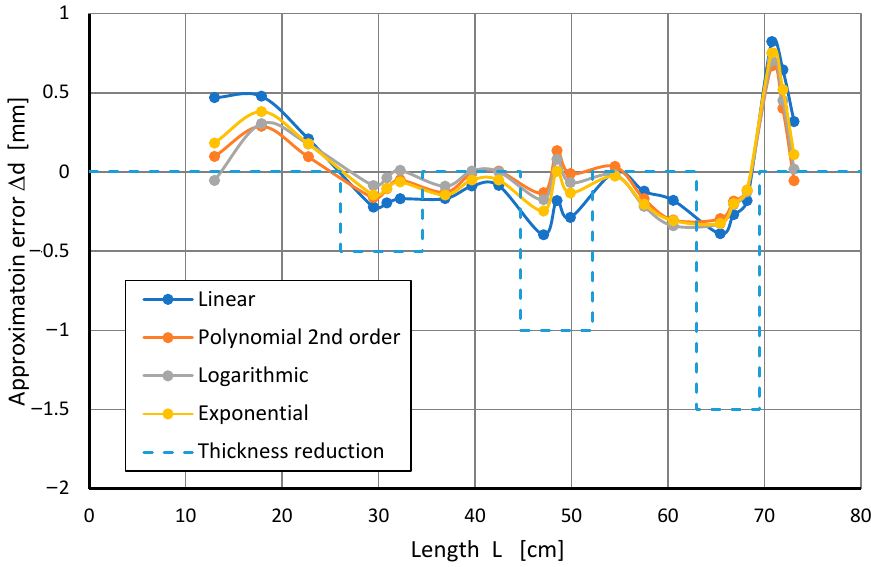
Figure 14. Approximation errors ˆ d for series VII of measurements. For a better assessment of the models used, approximation errors (related to the actual pipe wall thickness) were calculated, i.e., the maximum and minimum values of differences, as well as the RMSE. Outcomes for all measurements are presented in Table 3. Similarly to the M2 model, the best results were obtained for the second-order polynomial approximation model.